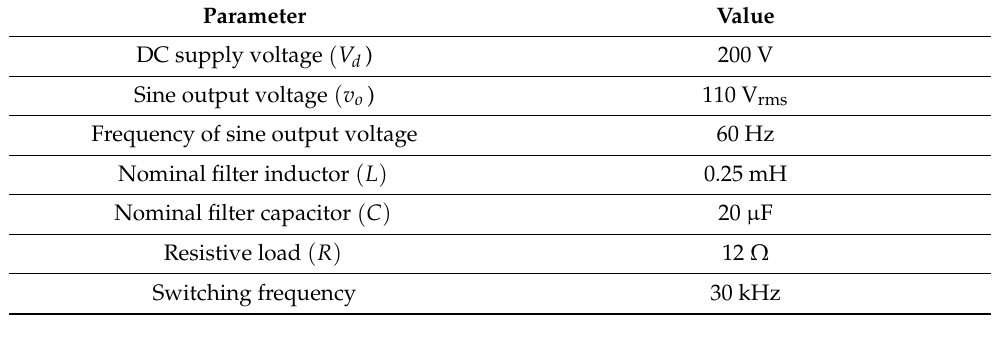
Table 1. Parameters of the inverter.